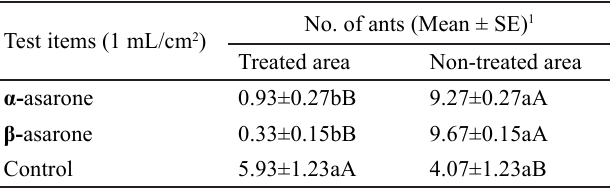
Table 4. Repellency of sweet flag powder to the Solenopsis invicta workers.